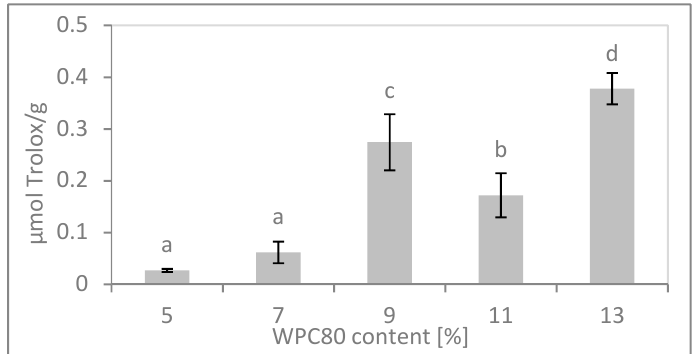
Figure 4. Effect of different WPC80 contents on antioxidant properties (DPPH) of high-protein fat- Figure 4. E ff ect of di ff erent WPC80 contents on antioxidant properties (DPPH) of high-protein fat-free free dairy desserts. Letters (a–d) indicate significant differences at p < 0.05 (Tukey’s HSD test). dairy desserts. Letters (a–d) indicate significant di ff erences at p < 0.05 (Tukey’s HSD test). Appl. Sci. 2020 , 10 , x FOR PEER REVIEW